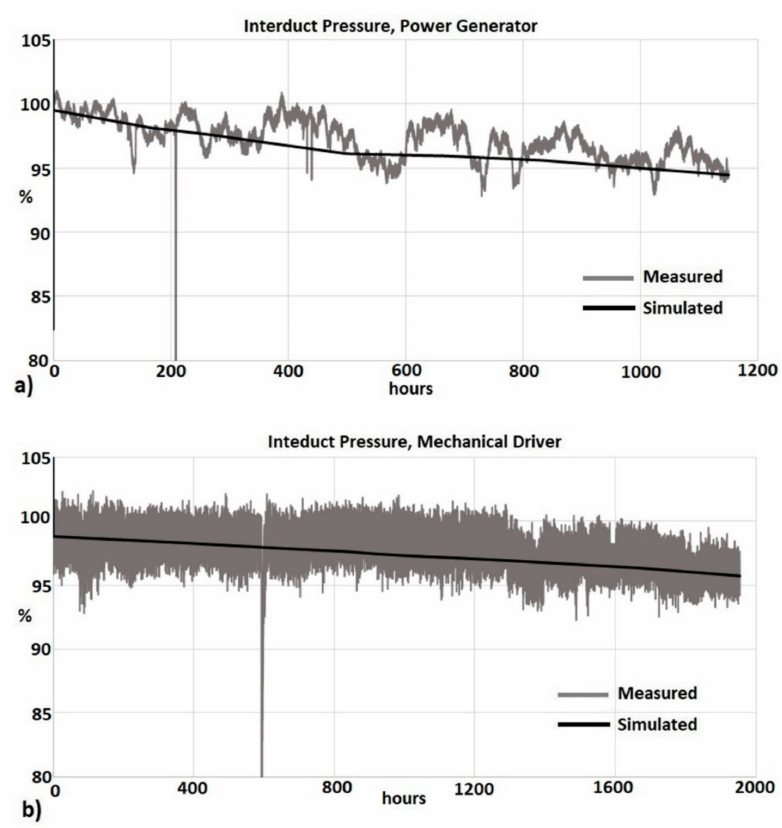
Figure 8. Measured and simulated interduct pressures: ( a ) power generator; ( b ) mechanical